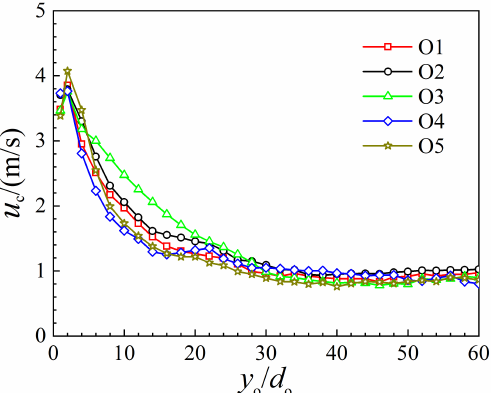
Figure 12. Jet centerline velocity at orifice O1 ∼ O5 with the synthetic jet operating at (100, 33.6).